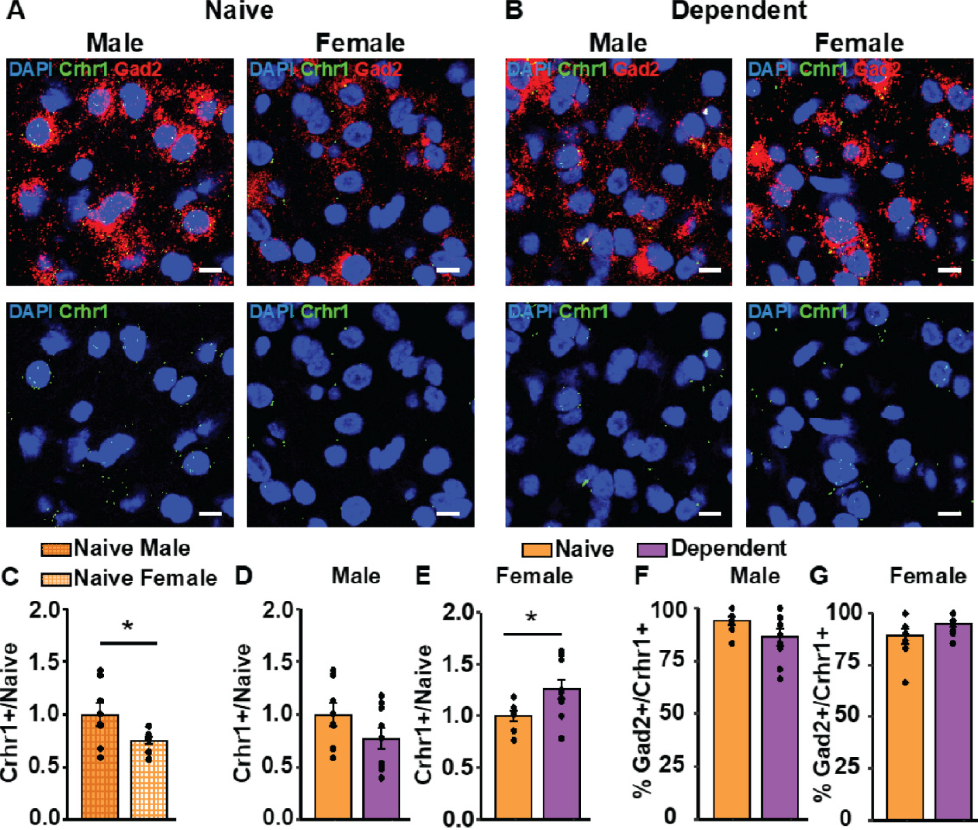
Figure 5. Alcohol dependence alters Crhr1+ cells in the central amygdala (CeA) of females. Repre- sentative images of Crhr1 (green), Gad2 (red), and DAPI (blue) for ( A ) naïve and ( B ) alcohol-dependent male ( left ) and female ( right ) rats in the CeA. Scale bar = 10 μ m. ( C – E ) Summary bar graphs indicating relative proportion of nuclei expressing Crhr1 (Crhr1+) between ( C ) naïve male and female rats, ( D ) naïve male and dependent male rats, and ( E ) naïve female and dependent female rats. ( F , G ) Summary bar graphs indicating the percentage of CeA nuclei co-expressing Gad2 in the Crhr1 + population ( Gad2 +/ Crhr1 +) in naïve and dependent male ( F ) and female ( G ) rats. n = 7–9 images from N = 3 rats/group; bars represent Mean ± SEM; * denotes p < 0.05.